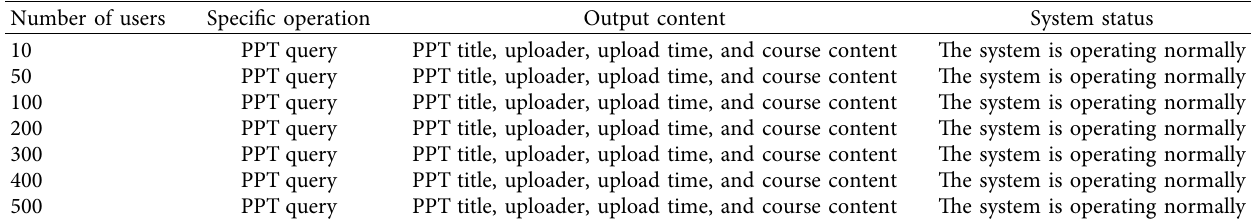
Table 2: The operation of the system under the largest concurrent user.